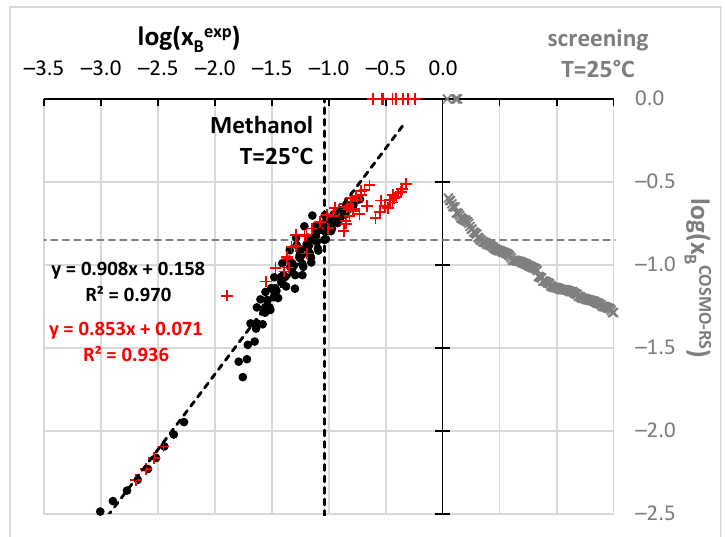
Figure 2. Results of benzamide solubility measurements and computations. All experimental points marked as black circles were taken from the literature while new measurements are presented as red plusses. Computed solubility values are presented in gray color. Dashed lines stand for best solubility values estimated so far at room temperature.